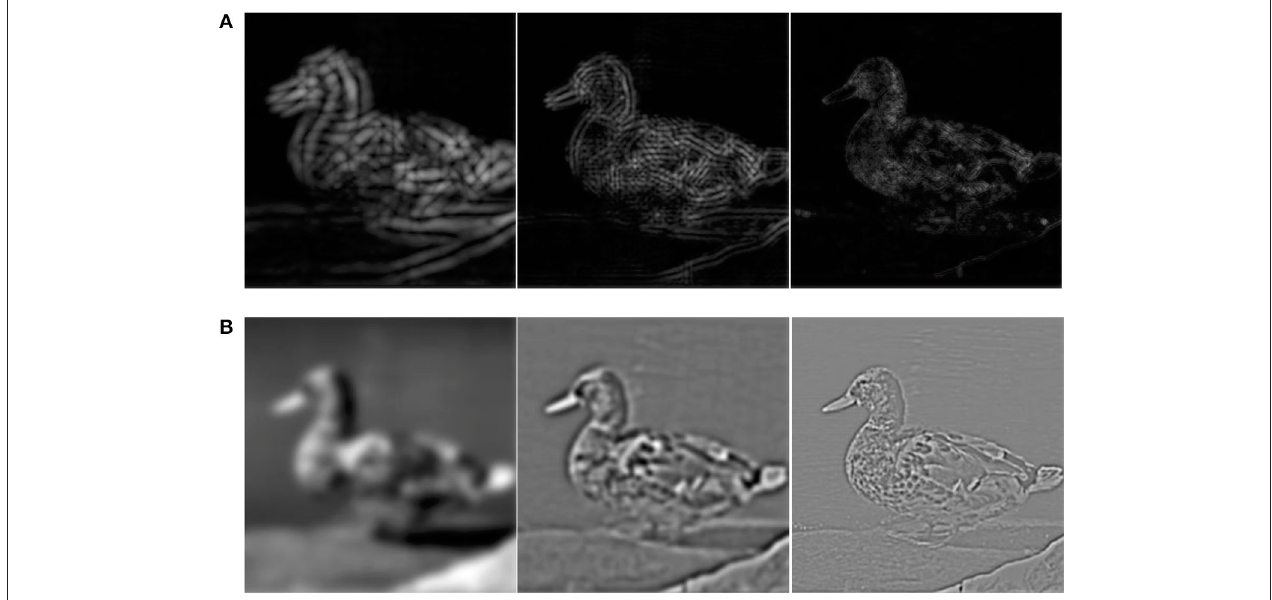
FIGURE 2 | A sample image filtered into different spatial frequency bands using Gabor filters and Gaussian bandpass filters. Image filtered into the LSF, ISF, and HSF bands are respectively shown from left to right. (A) Image of each frequency band is the accumulation of the outputs of Gabor filters in four orientations (0, 45, 90, and 135 ◦ ). (B) Gaussian bandpass filtered images using H LP 1 , H BP , and H HP 2 filters (see Section